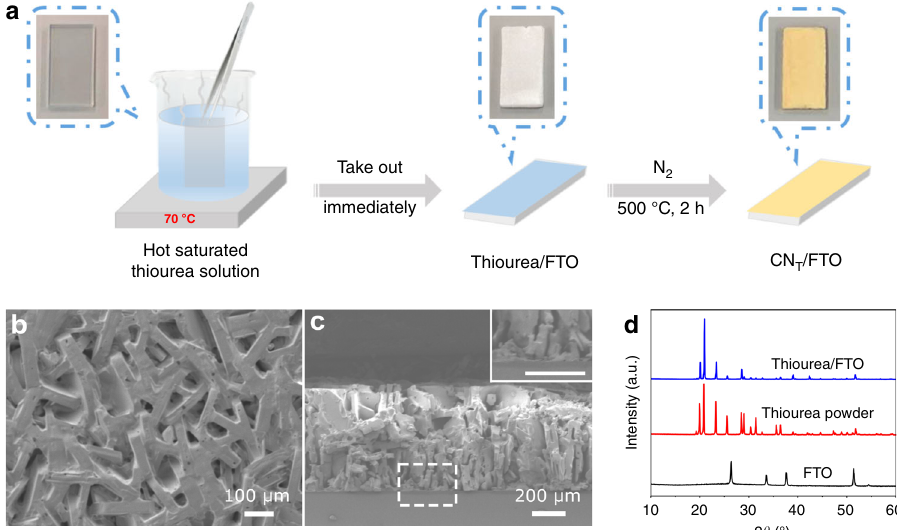
Fig. 1 Carbon nitride fi lm preparation from thiourea (CN T ). a The proposed synthesis process of CN T fi lm on FTO (the corresponding physical photos are shown within the dotted line). b Top-view SEM image of the thiourea fi lm on FTO. c Cross-sectional SEM image of a 3-layer thiourea fi lm on FTO (inset: a magni fi ed SEM image of the squared area). d XRD patterns of clean FTO, thiourea powder, and thiourea fi lm on